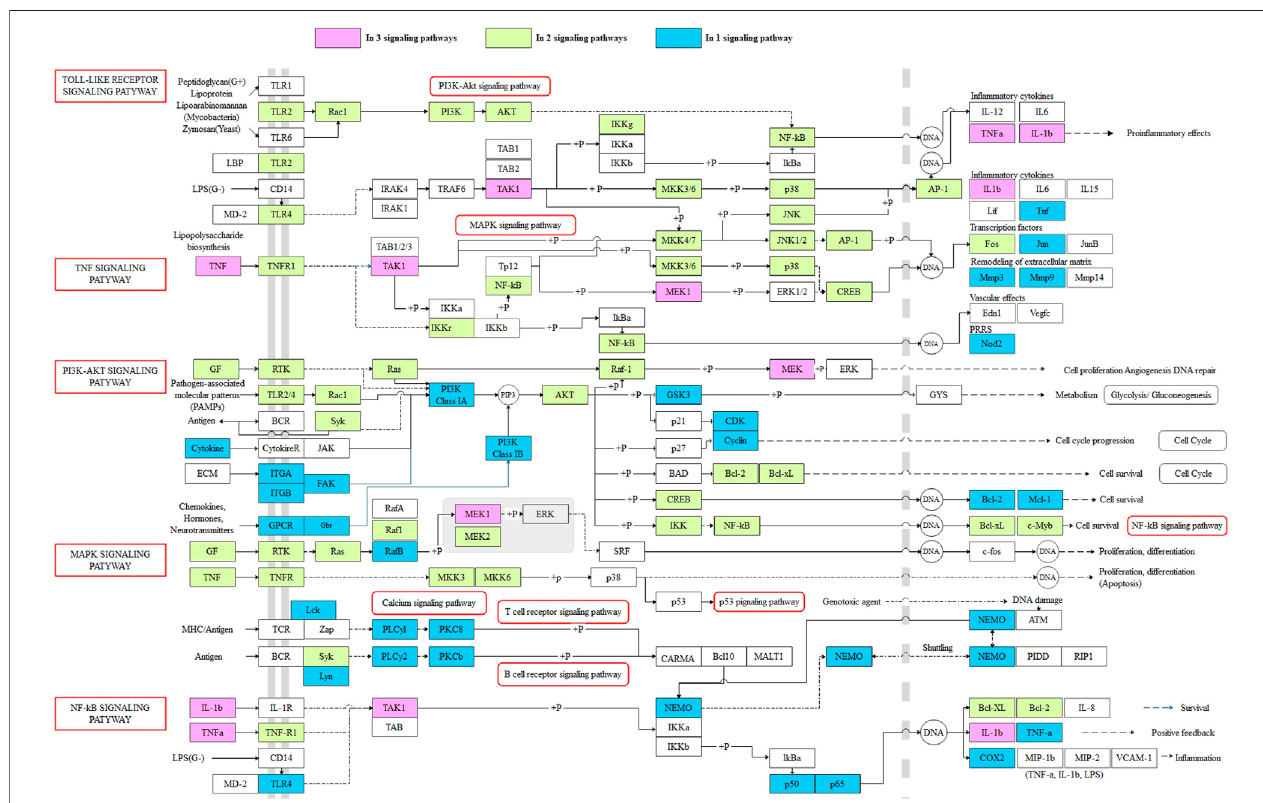
FIGURE9| Thecomprehensivepathway ofthetargets oftheCFIG. Pink represents theCFIGtargetsorproteins enriched inthree pathways, greenrepresentsthe CFIGtargetsorproteinsenriched intwopathways, bluerepresentstheCFIGtargetsorproteinsenrichedinonepathway,andthesignalingpathways aremarkedbyred